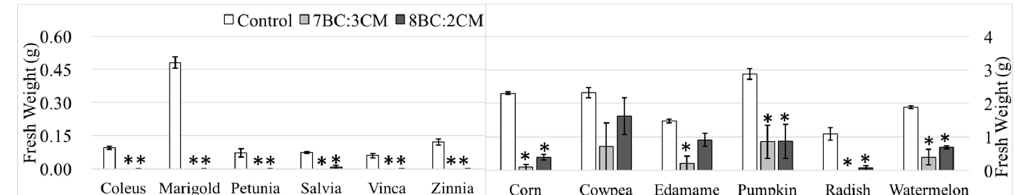
Figure 6. Fresh weights (mean ± standard error) of the seedlings in commercial propagation mix (control), 70% biochar:30% chicken manure compost (7BC:3CM, by volume), or 8BC:2CM in Experiment 3. The asterisks indicate differences from the control using Dunnett’s test at p < 0.05 ( n = 4).